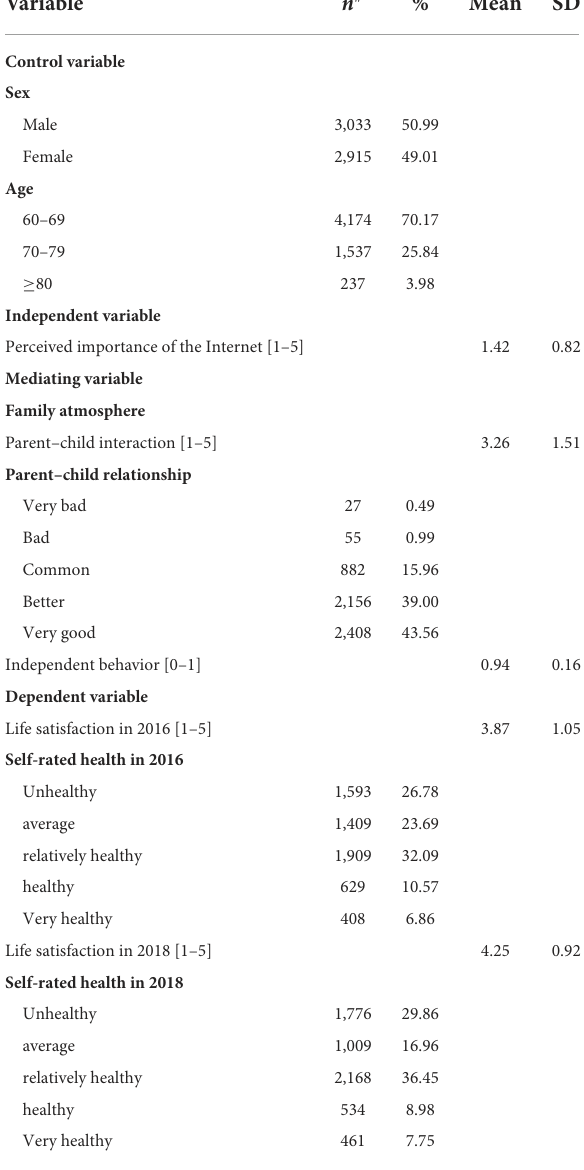
TABLE 1 Descriptive statistics variables of the sample ( n =